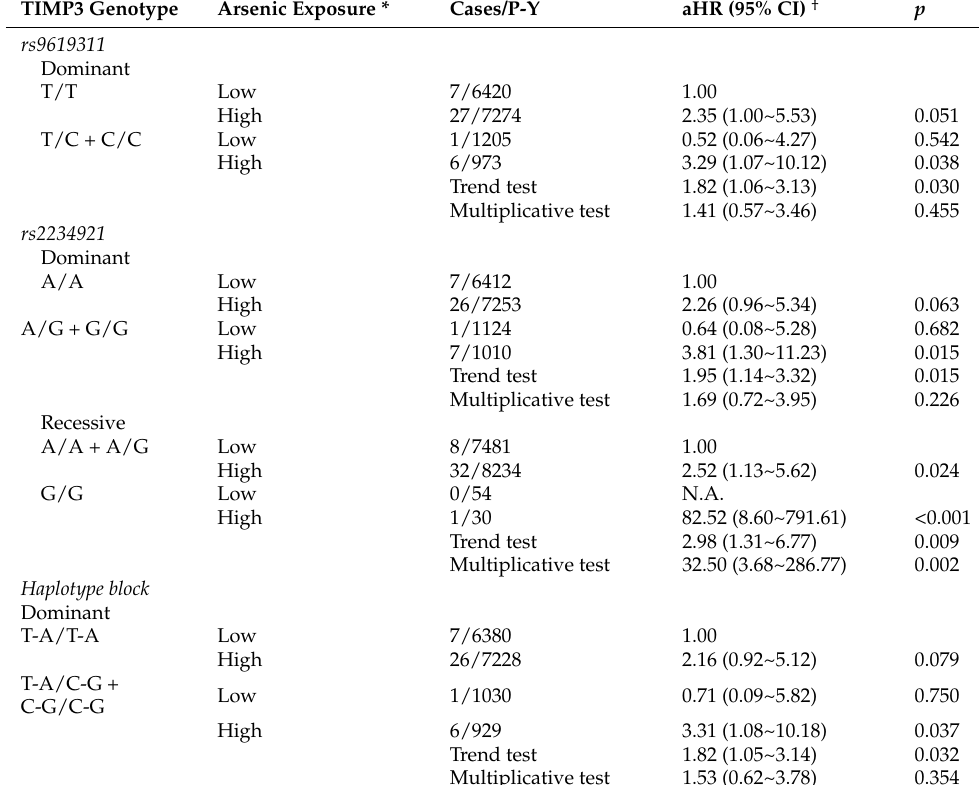
Table 4. Combined effects of TIMP3 genotypes and arsenic exposure on the risk of skin cancer. TIMP3